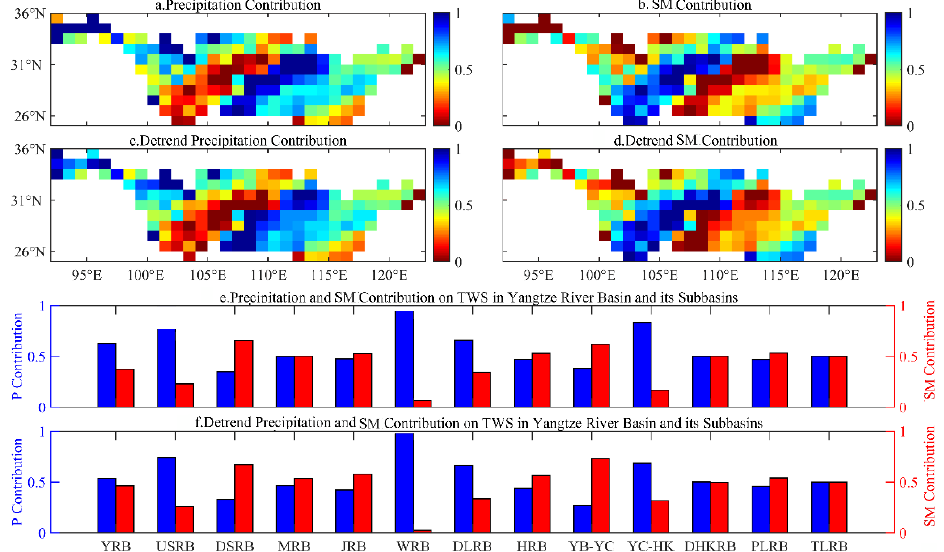
Figure 9. Relative contribution of original and de-trended precipitation and VIC-SMA on GRACE- TWSA in the YRB during April 2002–December 2019.